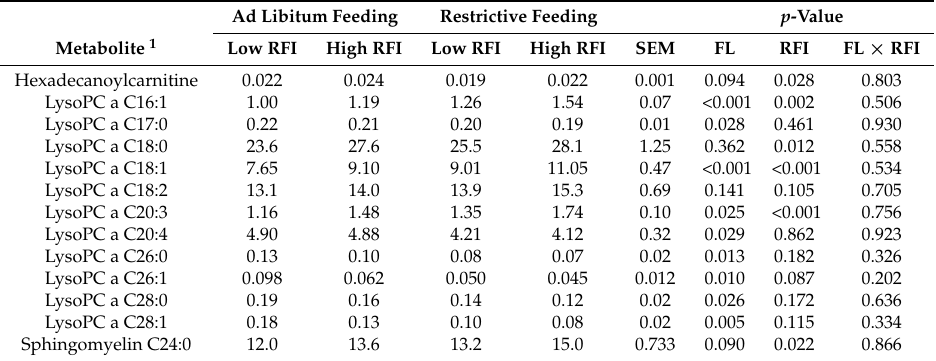
Table 2. Selected serum acyl-carnitine, lysophosphatidylcholines, and sphingomyelin ( µ mol/L) in low and high residual feed intake (RFI) broiler chickens fed either ad libitum or restrictively. Ad Libitum Feeding Restrictive Feeding p -Value Metabolite